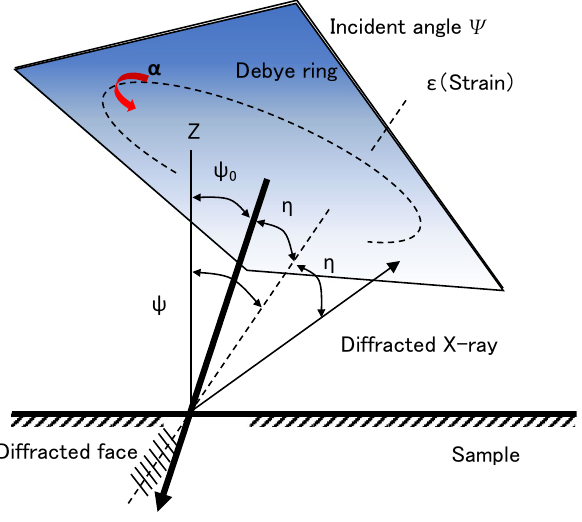
Fig. 4 Arrangement for the cos-α-method used to measure the dis- tance of the atomic layers